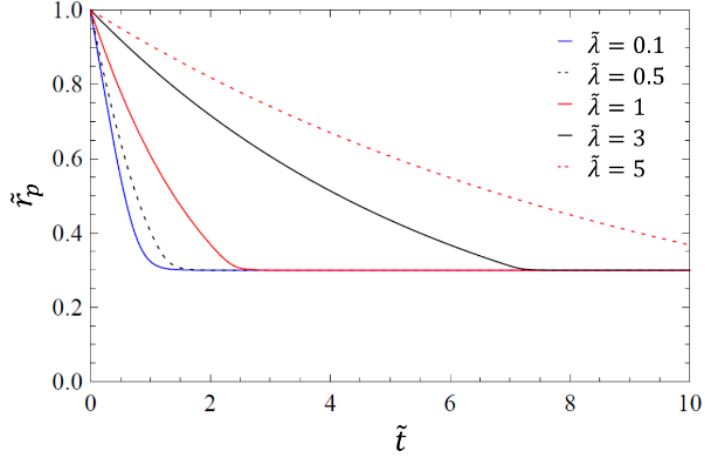
Figure 3. Solution curves for the viscoelastic model described in this paper for a constant equilibrium radius 𝑟̃ (cid:3043),(cid:3032)(cid:3044) = 0.3 and various relaxation times as indicated by the legend (adapted from [12]). If the ambient pressure of the surrounding melt is included, the energy work rate against the gaseous pressure (Equation (6)) is